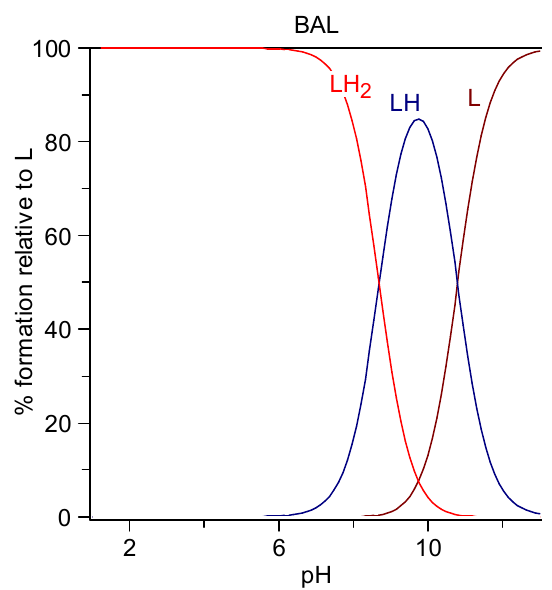
Figure 2. Speciation plots of British anti-Lewisite (BAL).